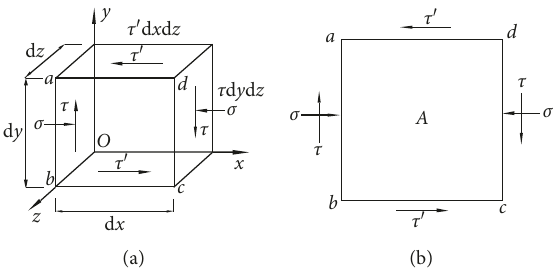
Figure 3: Schematic diagram of the stress state of the microelement body.